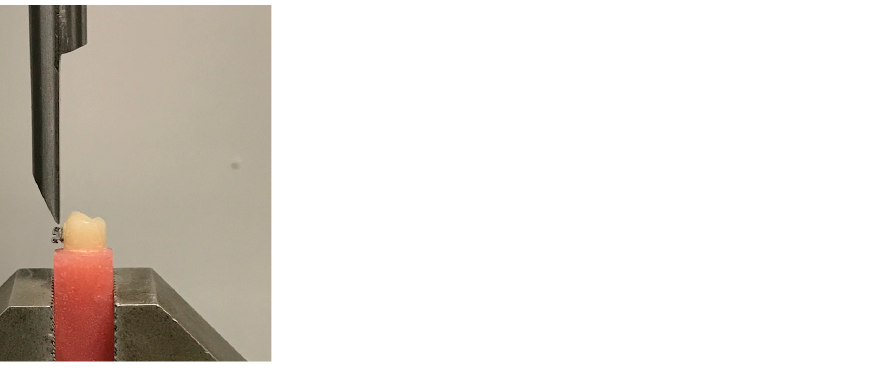
Figure 3. The Universal Testing Machine YLE (GmbH Waldstraße 1/1a, YLE GmbH Waldstrasse 1, D-64732 Bad Koenig, Germany).